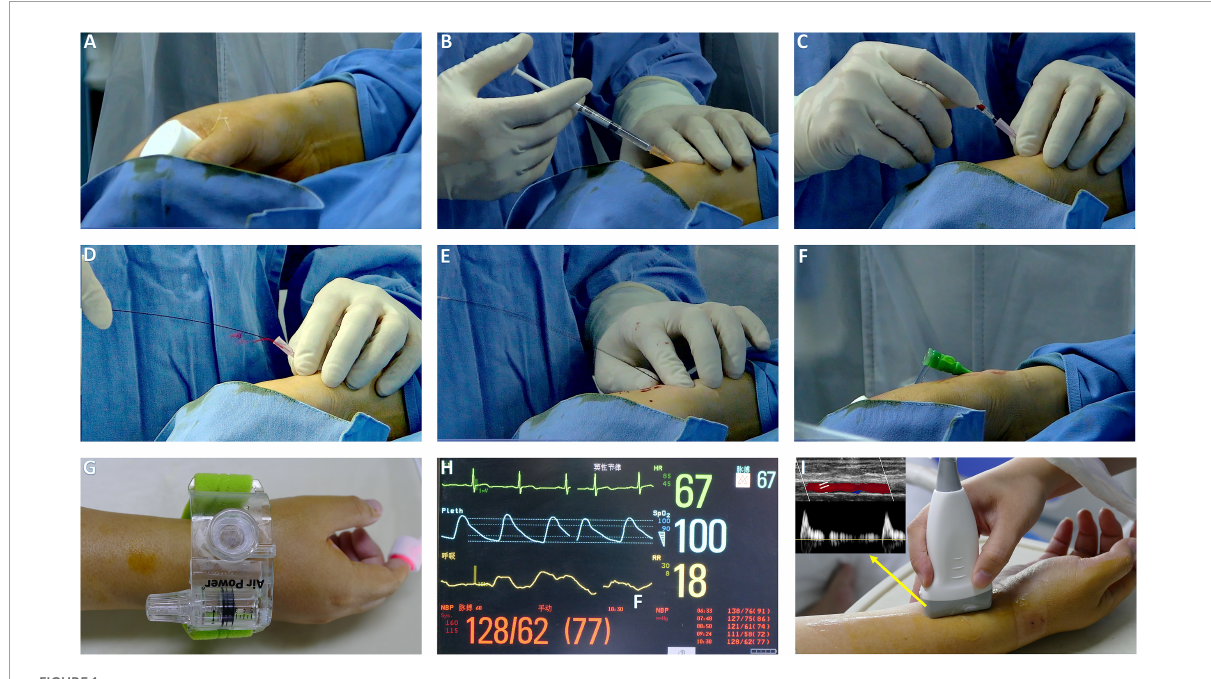
FIGURE1 The procedure setup of DRA. (A) The patient arm is placed with its lateral side facing upward, hold a roll of gauze. (B) Local anesthesia. (C) Puncture DRA with 20 G plastic cannula. (D) Pulsatile blood flow. (E) Introduction of miniguide wire. (F) The sheath in place. (G,H) Hemostasis with air power device and index finger for pulse oximeter. (I) Evaluation of radial patency by Doppler